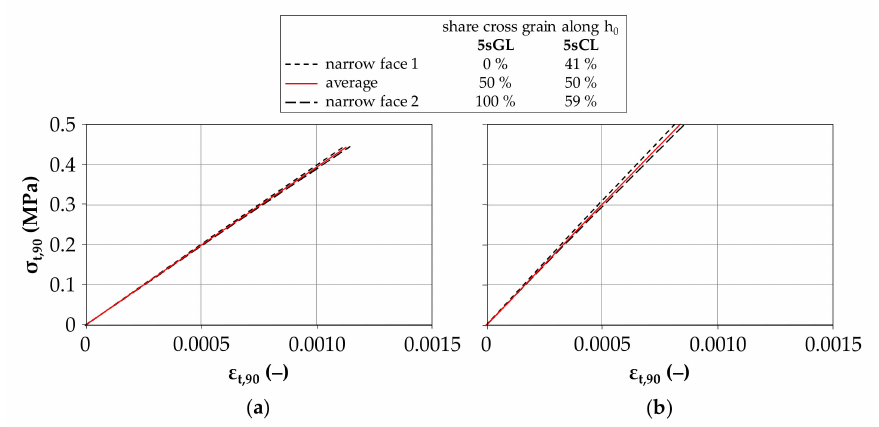
Figure 13. Stress-strain diagrams exemplarily for ( a ) specimen 2-10 of series 5sGL and ( b ) specimen 4-10 of series 5sCL; strain based on local displacement measurements of DD1